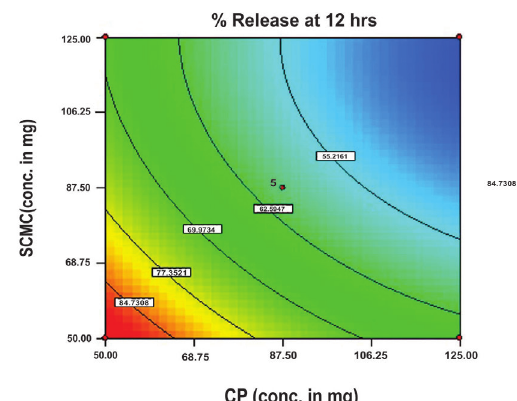
FIGURE 7 - Contour diagram showing the influence of CP and SCMC on the rel value of mucoadhesive tablet formulations 4hrs of flurbiprofen.